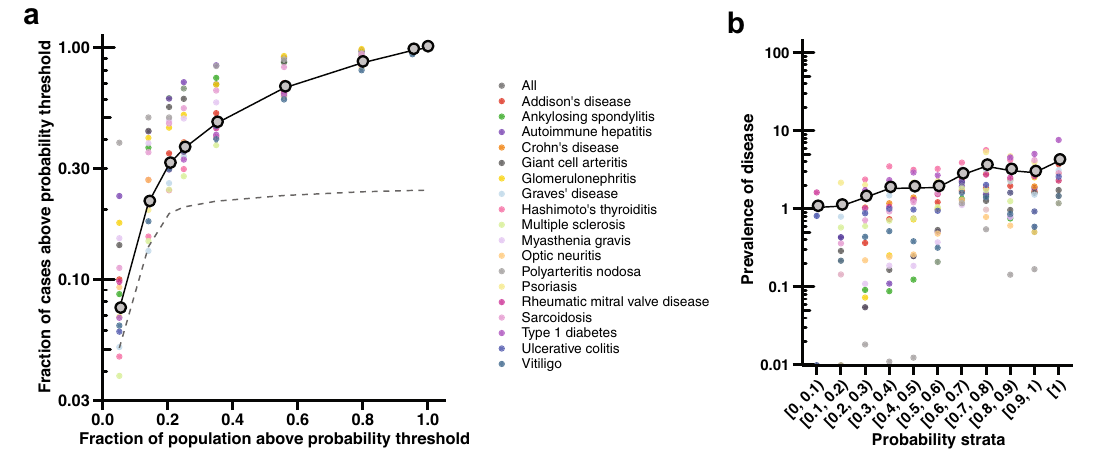
decreasing from left ( ≥ 0.9) to right ( ≥ 0.1) by increments of 0.1; the most lenient threshold( ≥ 0.1)atthefarthestrightcolumnofpointsyieldsthegreatestfractionof individuals with autoimmune conditions detected by the model and the greatest fraction of the population tested. b Prevalence of autoimmune conditions on a base-10logarithmicscaleindifferentstrataofprobabilitiesincreasingfrom0to0.1 [0, 0.1) through 1.